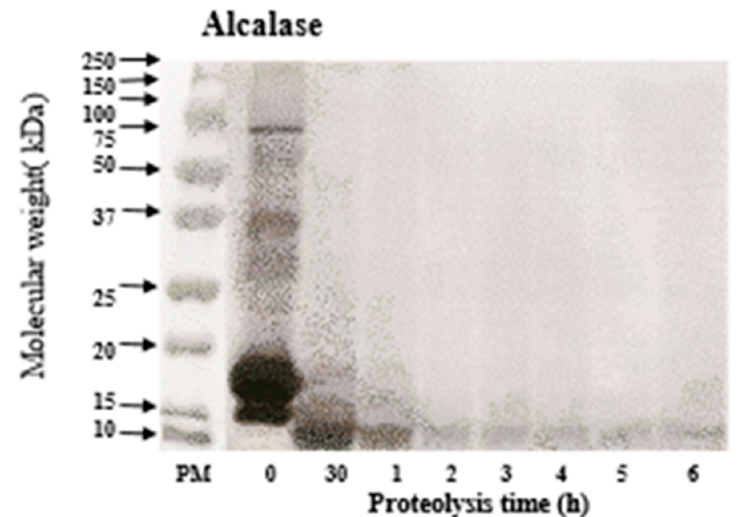
Figure 1. SDS-PAGE of native whey protein concentrate (WPC) and Alcalase-treated WPC at different hydrolysis hours.